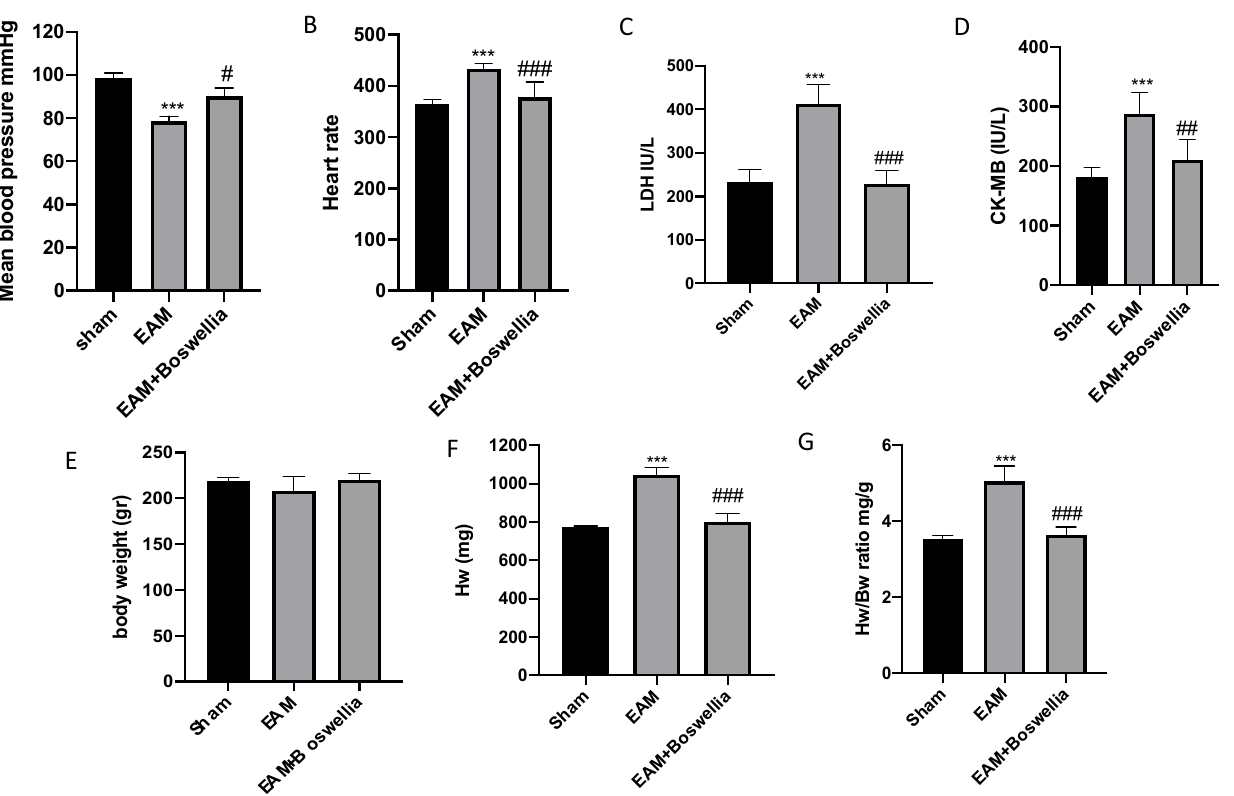
Figure 2. Effect of Boswellia extract on mean blood pressure, heart rate, Hw/Bw and biochemical parameters. Mean blood pressure and heart rate ( A , B ), serum levels of LDH ( C ), CK-MB ( D ), Body weight, Hw and Hw/Bw ( E – G ) measures at last day of experiment. Boswellia extract administration was able to ameliorate all these parameters. Values = means ± SEM of 6 animals for each set; *** p < 0.001 vs. sham; ### p < 0.001 vs. EAM ## p < 0.01 vs. EAM # p < 0.05 vs. EAM.